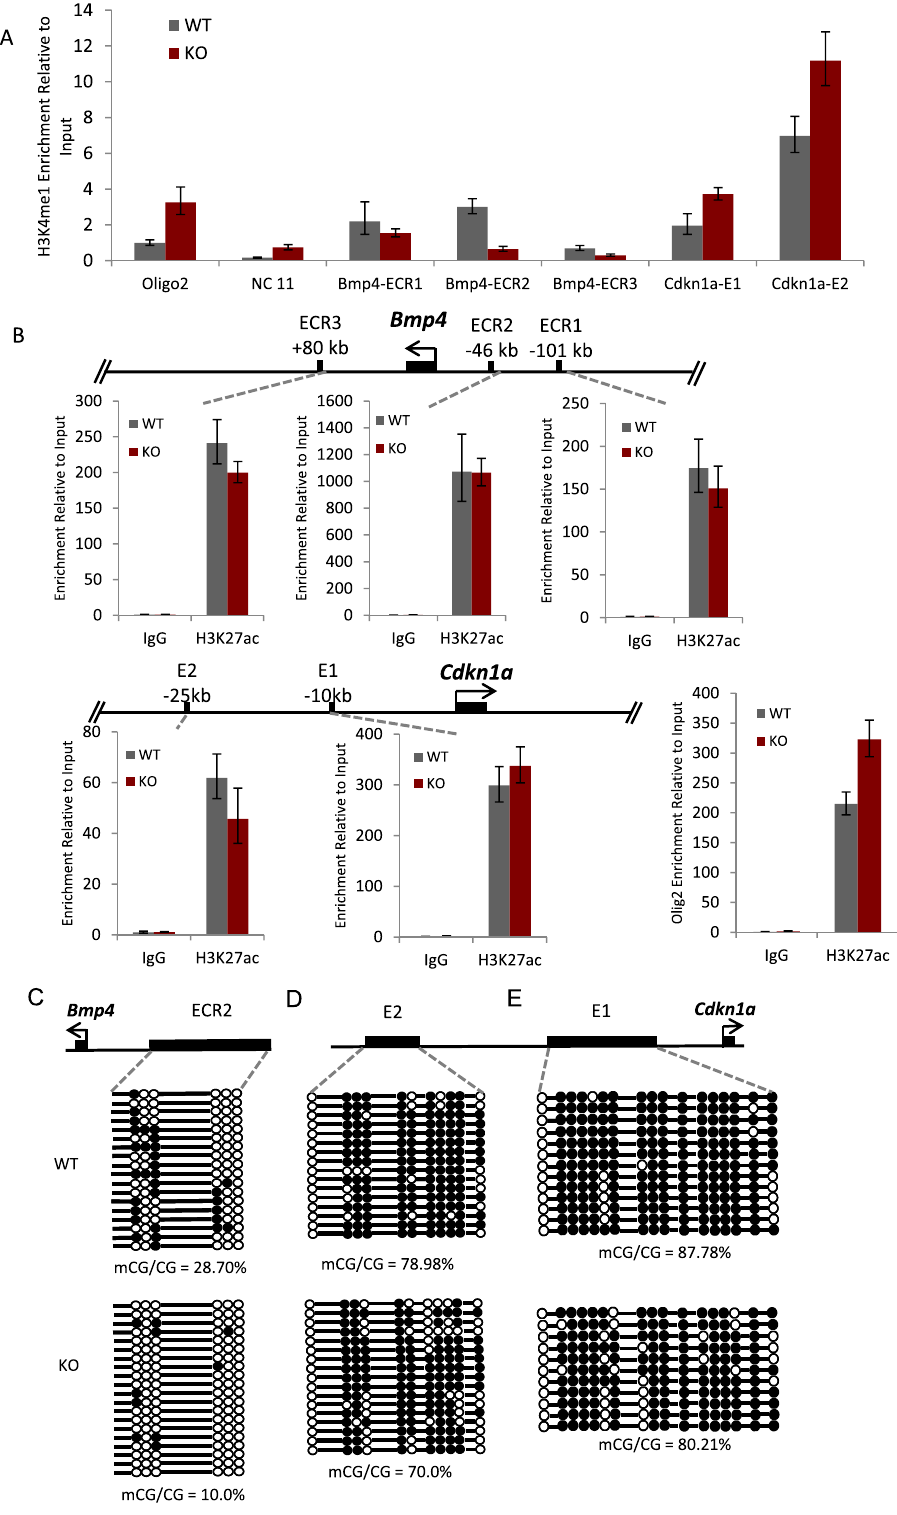
Figure 4. Altered epigenetic marks at Bmp4 and Cdkn1a enhancer regions. ( A and B ) ( A ) ChIP-qPCR assay for detection of histone marker H3K4me1 at Bmp4 enhancer regions and Cdkn1a enhancer regions as depicted in ( B ). Oligo2 and NC 11 represent positive and negative controls. ( B ) ChIP-qPCR assay for detection of histone marker H3K27ac at Bmp4 and Cdkn1a enhancer regions. Oligo2 served as positive control and Ig was used as negative control. ( C , D and E ) CpG methylation assessment by bisulfate sequencing assay on enhancer regions of Bmp4 ( C ) and enhancer regions of Cdkn1a ( D and E ). White circles represent unmethylated CpG sites, and black circles represent methylated CpG sites. WT and KO samples for BS assay n = 2. A similar reduction in CG methylation was observed in biologic repeats (Supplement Fig.